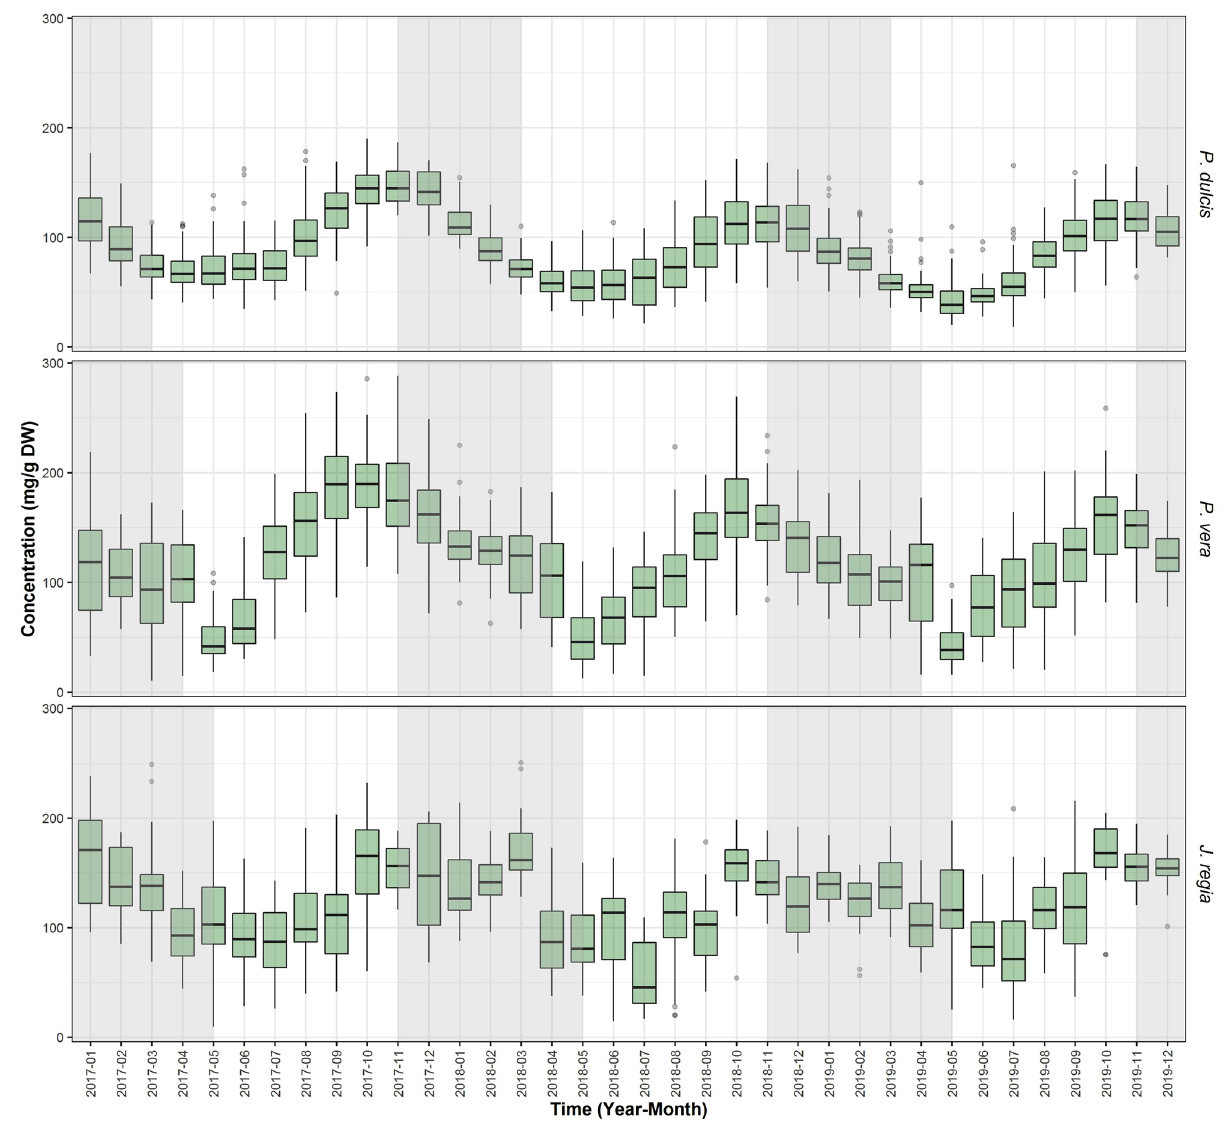
Figure 2. Multiyear seasonal trends of total NSC of three species. Average concentration of total NSC (SC + St) from all sites in California for P. dulcis, P. vera , and J. regia from January 2017 to December 2019. The lower and upper hinges correspond to the first and third quartiles (the 25th and 75th percentiles). The upper whisker extends from the hinge to the largest value no further than 1.5*IQR from the hinge (where IQR is the inter- quartile range, or distance between the first and third quartiles). The lower whisker extends from the hinge to the smallest value at most 1.5*IQR of the hinge. Grey shading reflects the dormancy period of each